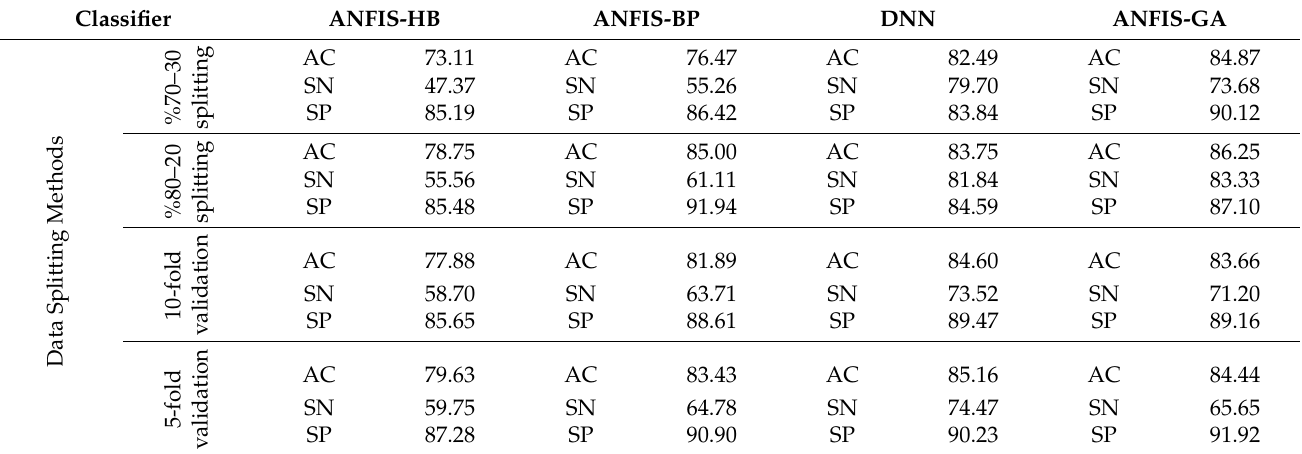
Table 4. The performance of the proposed method compared to conventional methods for 8 signs.